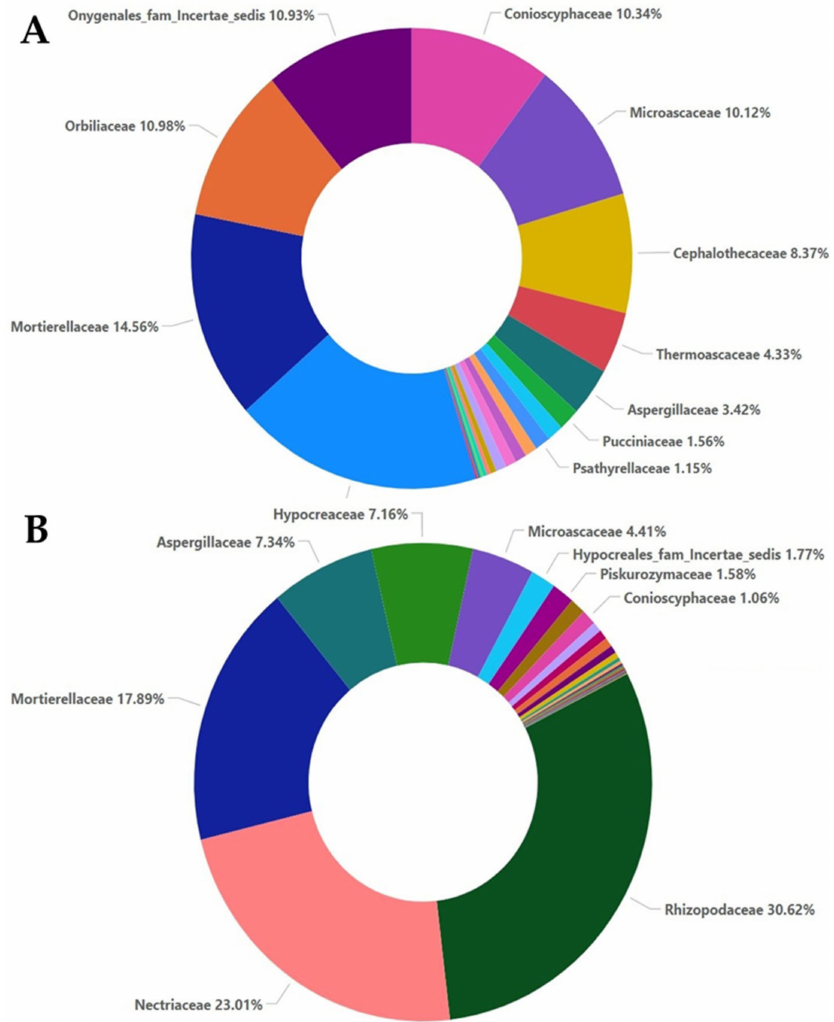
Figure 4. Relative abundance with percentages for the family taxa in the non-inoculated samples ( A ) and inoculated samples ( B